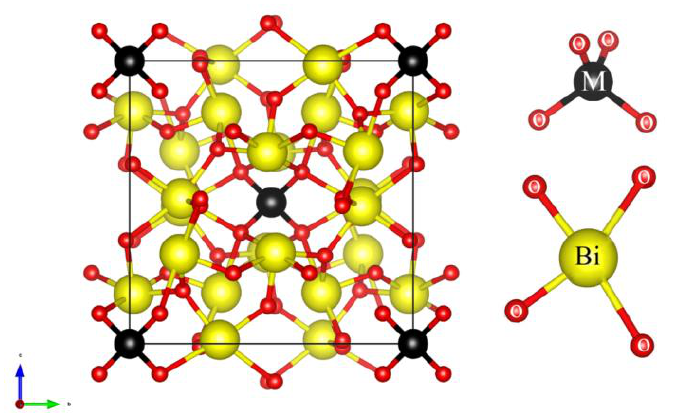
Figure 1. Crystal structure of the perfect Bi 12 MO 20 and local structure around the Bi and the M sites [61].